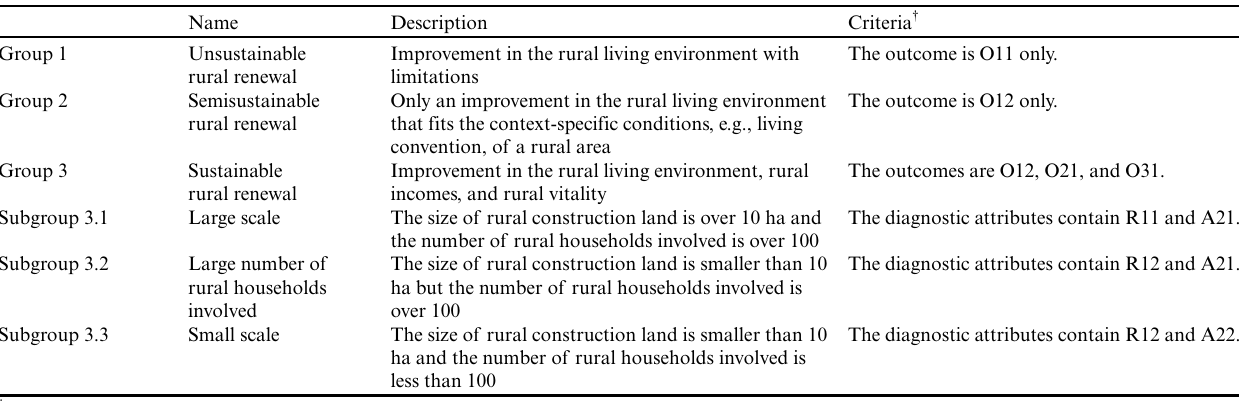
Table 1 . Classification of cases.